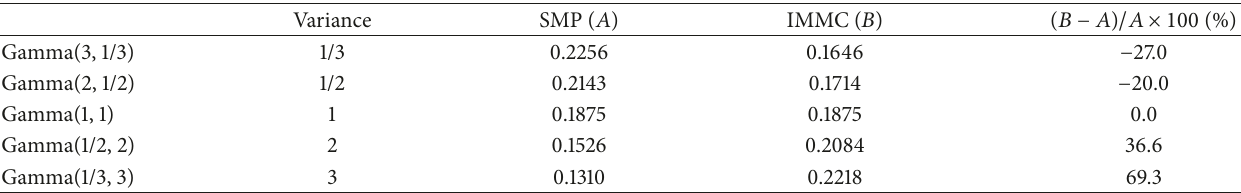
Table 3: Registration cost for various variances ( 𝐷 = 2 , 𝑇 𝑚 ∼ Gamma( 𝛼 , 𝛽 ), 𝐸(𝑇 𝑚 ) = 1 ).